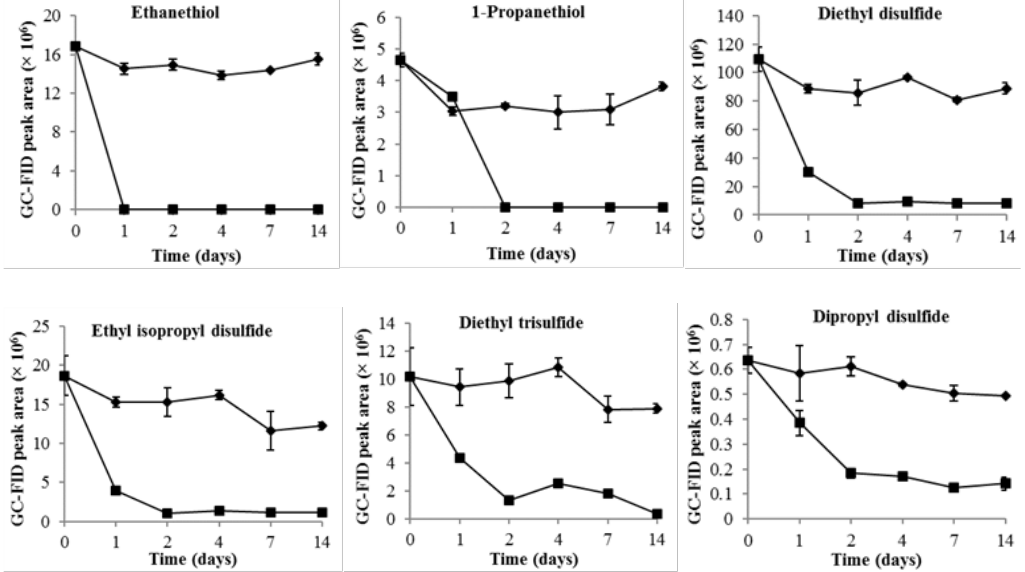
Figure 1. Changes of VSCs during durian wine fermentation and in durian pulp control. Durian wine fermentation ( ■ ), durian pulp control ( ◆ ).